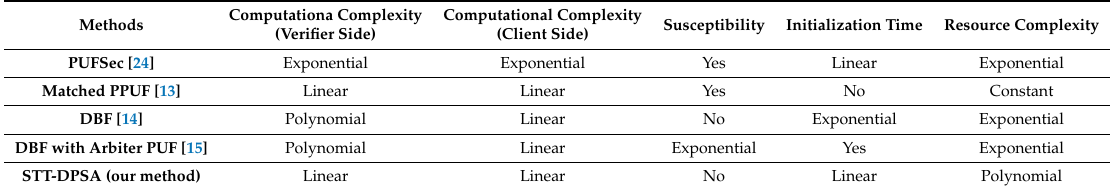
Table 1. Comparisons.